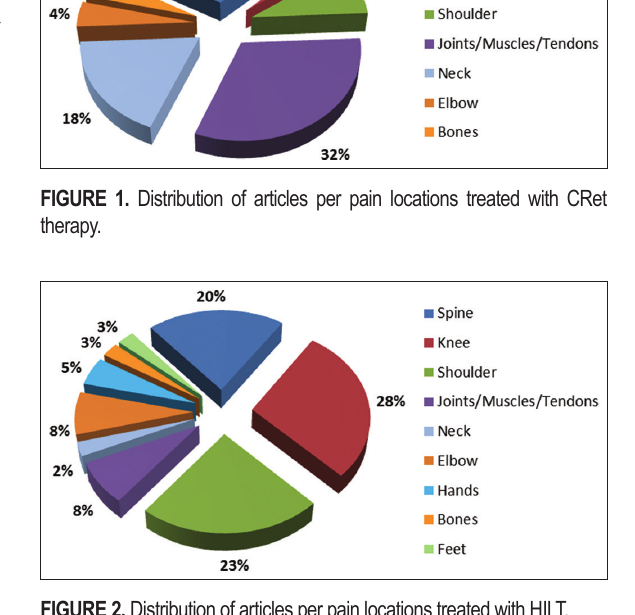
FIGURE 2. Distribution of articles per pain locations treated with HILT.